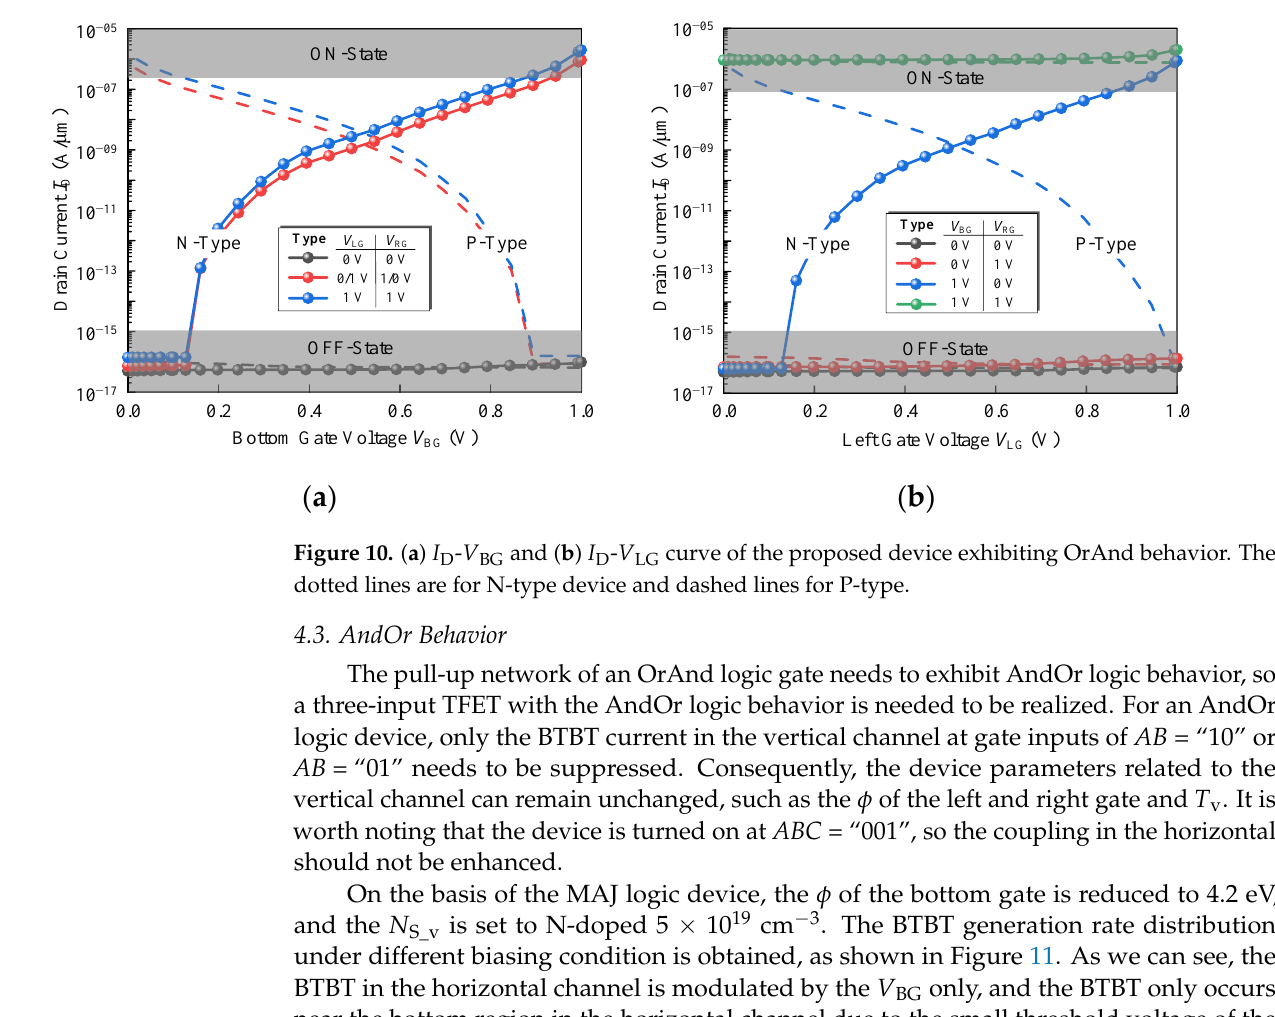
( b ) Figure 12. ( a ) I D - V BG and ( b ) I D - V LG curve of the proposed device exhibiting AndOr behavior. The dotted lines are for N-type device and dashed lines for P-type. 5. Discussion After optimizing the device parameters, critical electrical performances are summa- rized in Table 3, demonstrating correct logic behavior with I on / I off ratio of more than 10 − 9 . We also applied a small signal voltage of 1 MHz to the proposed device and extracted the parasitic capacitance curve, as shown in Figure 13. For the three-input TFET, the inversion layer is only connected to the drain, resulting in the gate – drain capacitance constituting a higher fraction of gate – gate capacitance C gg [28]. Since the V RG is fixed at 1 V, the inversion first occurs in the horizontal channel near the right gate, with the right gate – drain capac- itance C RGD accounting for a large proportion of C gg . When the V BG is scanned to 1 V, the bottom gate – drain capacitance C BGD and C RGD are equal. The TFET s have a large Miller capacitance ( C GD ) compared to MOSFET; thus, obtain the larger overshoot resulting in a degradation of switching characteristics. Referring to [28], the C GD can be reduced through design improvements made to the drain dopant profile or through L g scaling. Table 3. Important electrical performances of the proposed devices and logic gates. Logic Behavior